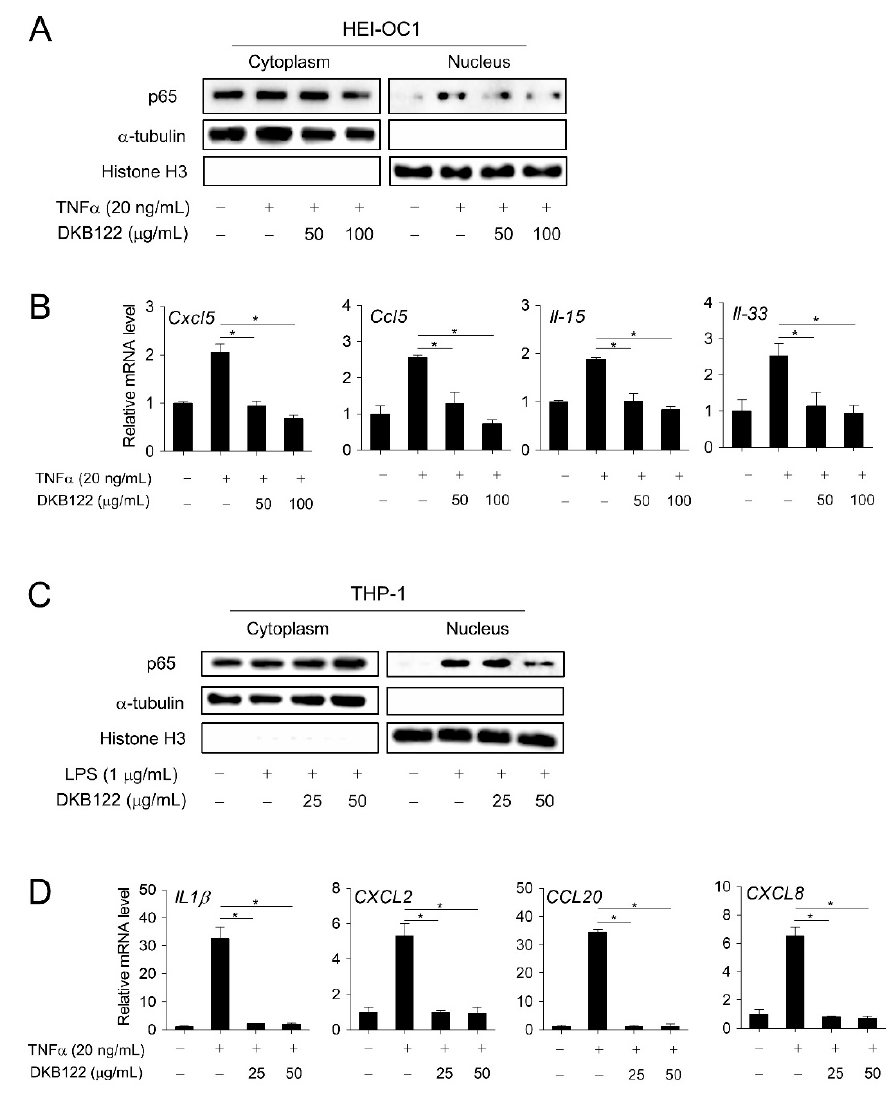
Figure 5. Inhibition of inflammatory gene expression by DKB122 in HEI-OC1 and THP-1 cells. ( A ) HEI-OC1 cells were pretreated with DKB122 (50–100 µ g / mL) for 24 h before exposing to TNF- α (20 ng / mL, 2 h). Cells were fractionated into the cytoplasmic and nuclear fractions. p65 levels were determined by western immunoblotting using a specific anti-p65 antibody. α -Tubulin and histone H3 were used as an internal control for cytoplasmic and nuclear fractions, respectively. ( B ) HEI-OC1 cells were pretreated with DKB122 (50–100 µ g / mL) for 24 h, then treated with TNF- α (20 ng / mL) for an additional 2 h. Total RNA was harvested and examined by RT-qPCR. mRNA levels of each gene were normalized to 18S rRNA. The results are presented as mean ± SD of three independent experiments ( n = 3, * p < 0.05). ( C ) THP-1 cells were pretreated with DKB122 (25–50 µ g / mL) for 1 h, then LPS (1 µ g / mL, 30 min). p65 levels in the cytoplasmic and nuclear fractions were determined by western immunoblotting as in Figure 4A. ( D ) THP-1 cells were pretreated with DKB122 (25–50 µ g / mL) for 1 h and then with TNF- α (20 ng / mL) for an additional 6 h. Total RNA was harvested and examined by RT-qPCR. mRNA levels of each gene were determined as in Figure 4B. The results are presented as mean ± SD of three independent experiments ( n = 3, * p < 0.05).